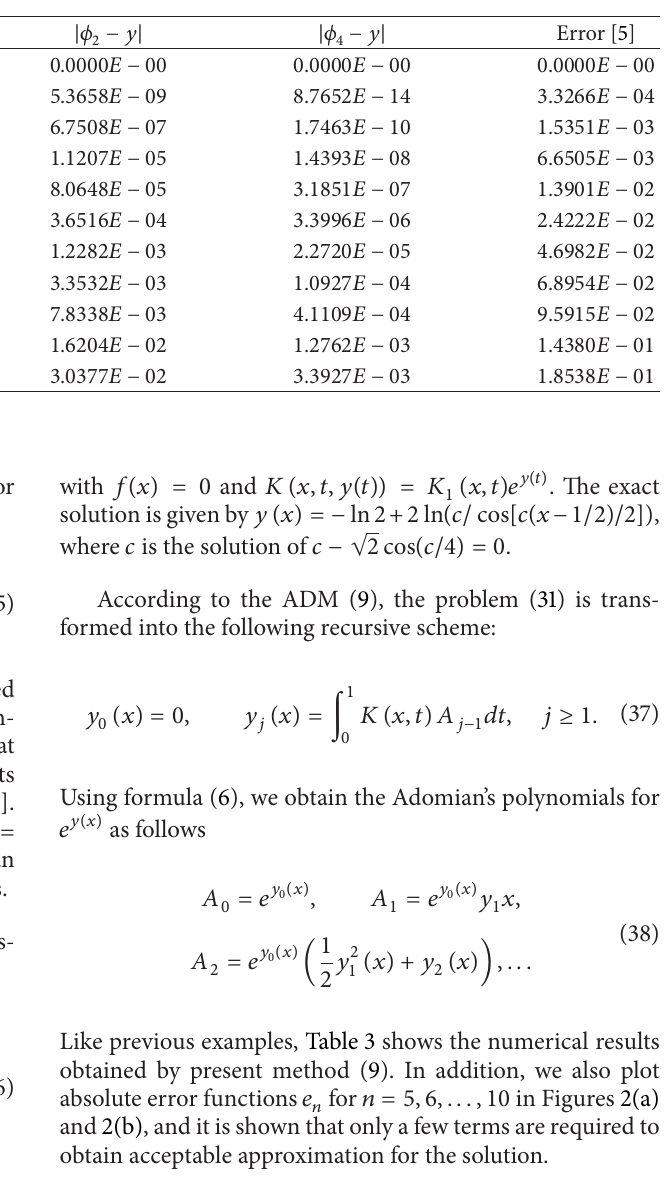
Table 2: Numerical solution and absolute error of Example